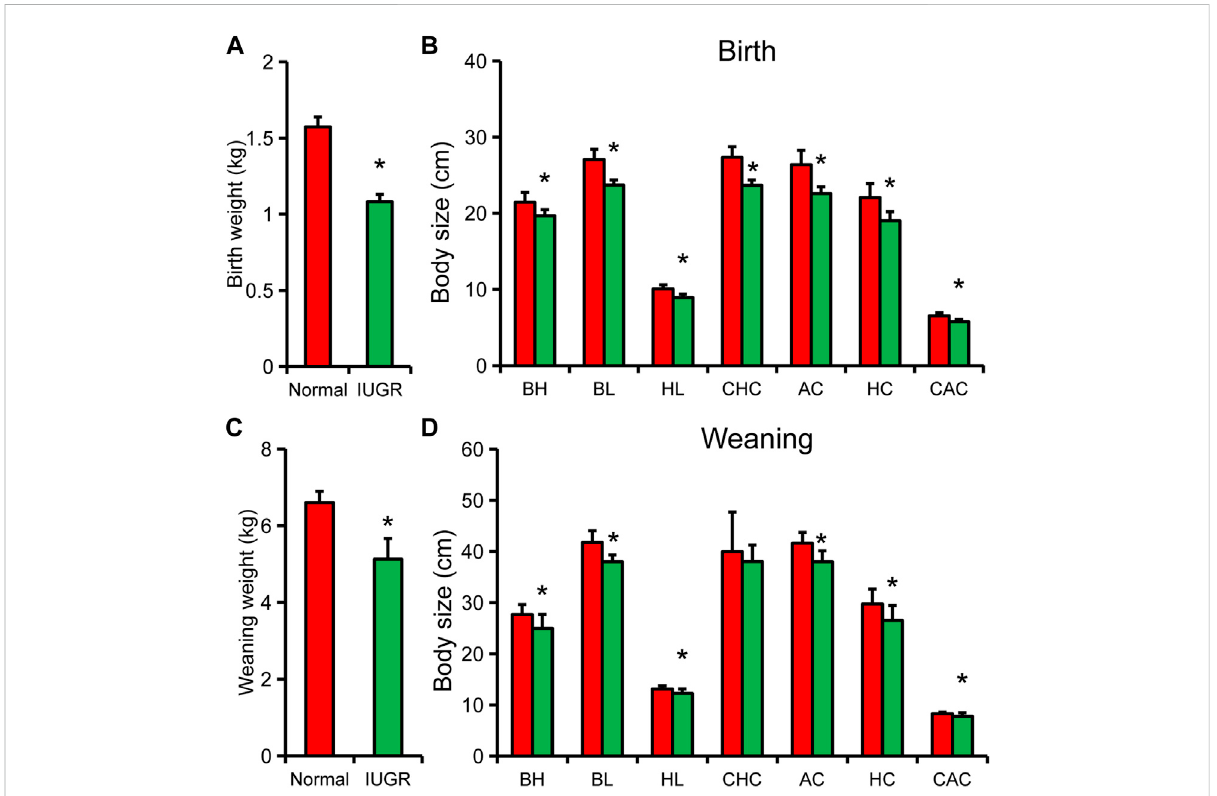
FIGURE 1 Differencesinbodyweightandbodysizebetweenintrauterinegrowthrestriction(IUGR)andnormal-sizepigs. (A) WeightofnewbornIUGRand normal-size pigs. (B) Body size indexes of newborn IUGR and normal-size pigs. (C) Body weight of IUGR and normal-size pigs at weaning. (D) Body size of IUGR and normal-size pigs at weaning. Results are presented as means ± SEM (N = 8); * indicates statistical signi fi cance ( p < 0.05). BH, body height; BL, body length; HL, head length; CHC, chest circumference; AC, abdominal circumference; HC, hip circumference; CAC, cannon